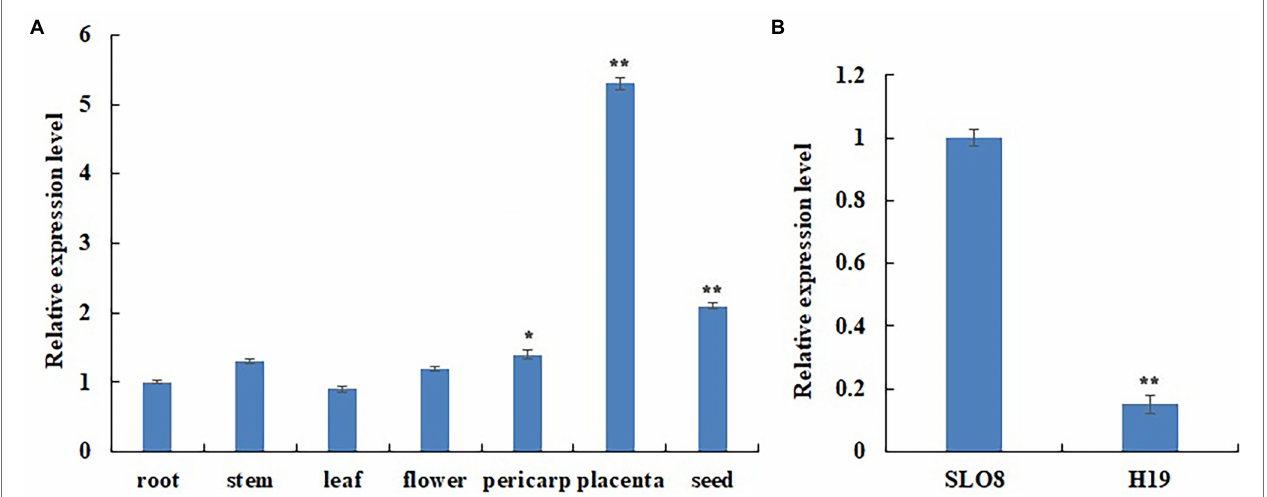
FIGURE 2 | Differential expression assays of CcERF2 . (A) Differential expression assays of CcERF2 in different tissues of pepper inbred line SL08; Roots, stems, leaves and flowers were collected from 30-day-old seedlings. Fruits at 24 days after pollination (DAP) was collected and was divided into pericarps, placentas and seeds. The relative expression of the root was set to 1, and that of all the other tissues was measured relative to that of the root. (B) Differential expression assays of CcERF2 in pepper inbred line SL08 and H19 fruits. Fruits at 24 DAP was collected to investigate the CcERF2 expression. The relative expression of the SL08 was set to 1, and that of H19 was measured relative to that of the SL08. The experiments were replicated three biological times and three technical times. Data are expressed as the mean ± SD ( n = 9). Student’s t -test was used to identify significant differences compared to the control (* p < 0.05, ** p <